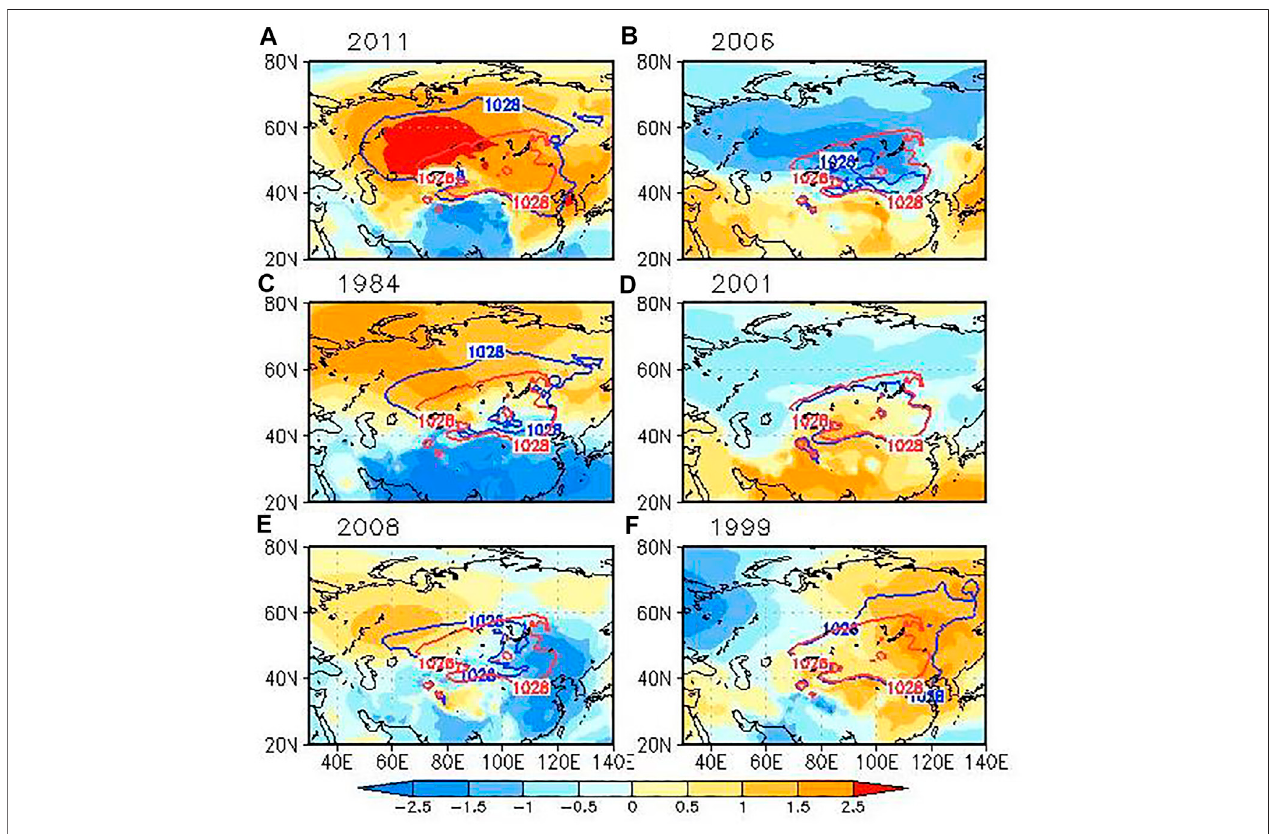
FIGURE2 | The distribution ofthe 1,028-hPaSLP contour in typical cases of theSH-EOF1mode (blueline; A,B ),the SH-EOF2 mode (blueline; C,D ),and the SH- EOF3 mode (blue line; E,F ). The climate mean 1,028-hPa SLP contour is represented by the red line and the standardized anomalies of SLP are shaded.